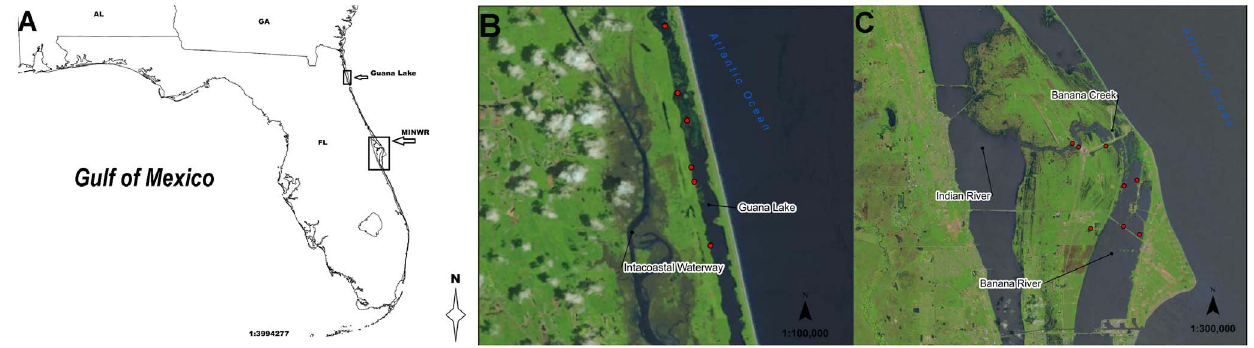
Figure 1. Study sites and capture locations. A) Map of southeastern United States, study areas are labeled by black boxes. B) Map of Guana Lake. C) Map of Merritt Island National Wildlife Refuge (MINWR). Red circles indicate capture and release locations of American alligators outfitted with Crittercam units. All image data was sourced from USGS National Map Viewer: http://viewer.nationalmap.gov/viewer/. Maps were created with Grass GIS analysis software (CC-BY-SA): http://grass.osgeo.org/.